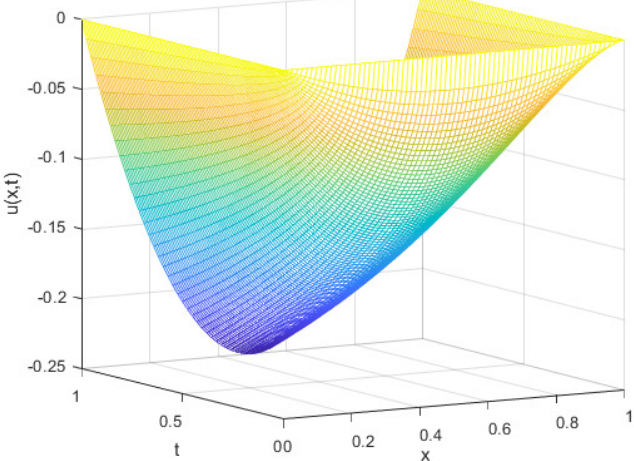
Figure 6. Exact solution surface for Example 2. ( α = 0.5).